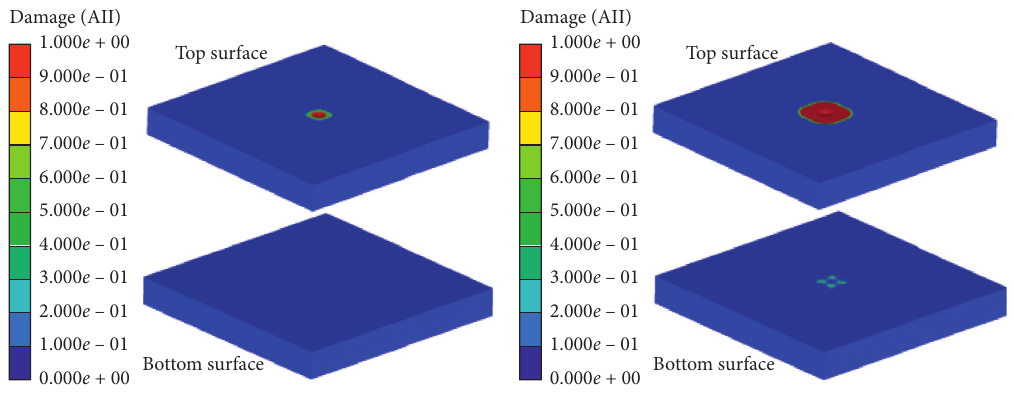
0.2Spherical charge Cylindrical charge, L / D = Cylindrical charge, L / D = 0.6 Cylindrical charge, L / D = 1.0 Cylindrical charge, L / D = 2.0 Cylindrical charge, L / D = 5.0 Figure 22: Comparison of peak velocities at targets from the spherical and cylindrical explosives.